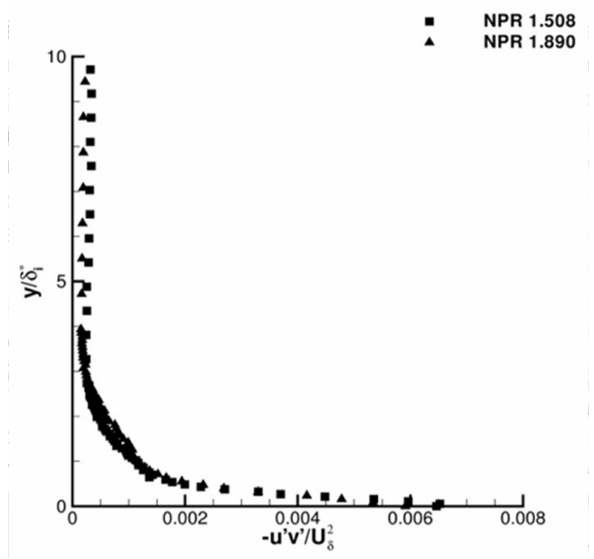
Figure 17. LU60P nozzle exit shear stress